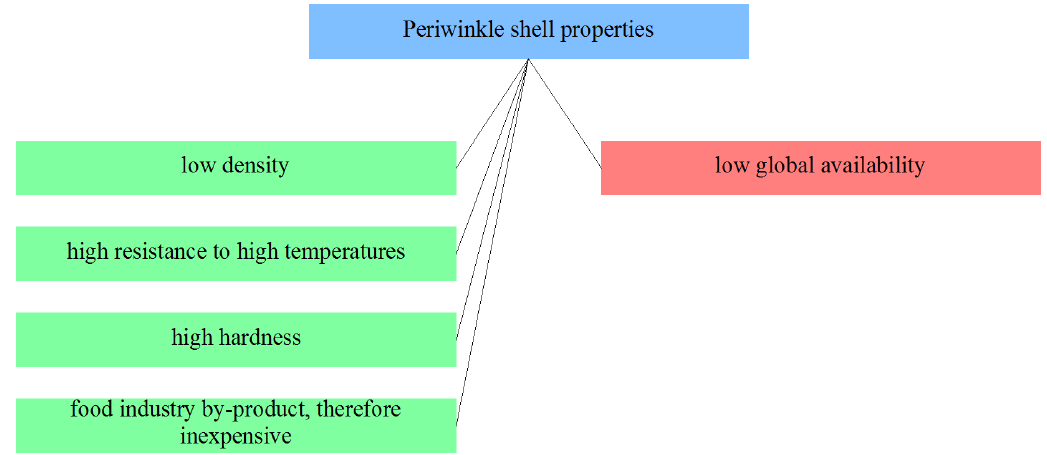
Figure 16: Selected periwinkle shell properties from the point of view of applicability in friction